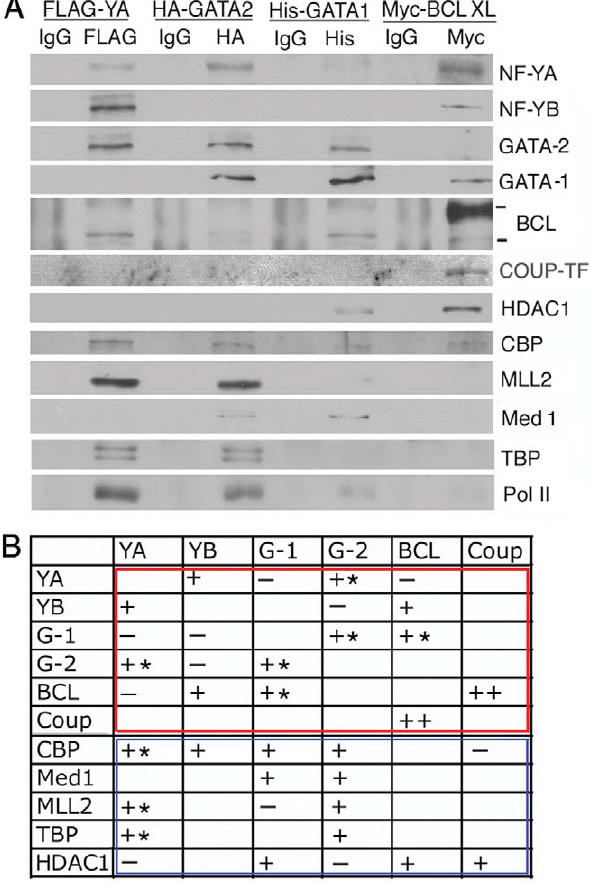
Figure 6. Protein interaction network in the proximal c -globin promoter complex. A. Western blots of proteins co-immunoprecip- itated with tagged NF-YA, GATA-2 or -1 or BCL11A-XL expressed from plasmids transfected into K562 cells. B. Pair-wise in vitro interactions between purified transcription factors and co-factors. Pair-wise interactions within the red frame: in vitro interactions between transcription factors. Pair-wise interactions within the blue frame: in vitro interactions between transcription factors and co-factors. ++ , + , 2 : strong, average or no interaction between the proteins. Interactions marked with *: the proteins in the pair-wise interaction were isolated from both K562 and HEK293 transfected with the expression plasmids for the target proteins. Otherwise, the proteins were isolated from transfected HEK293 cells.